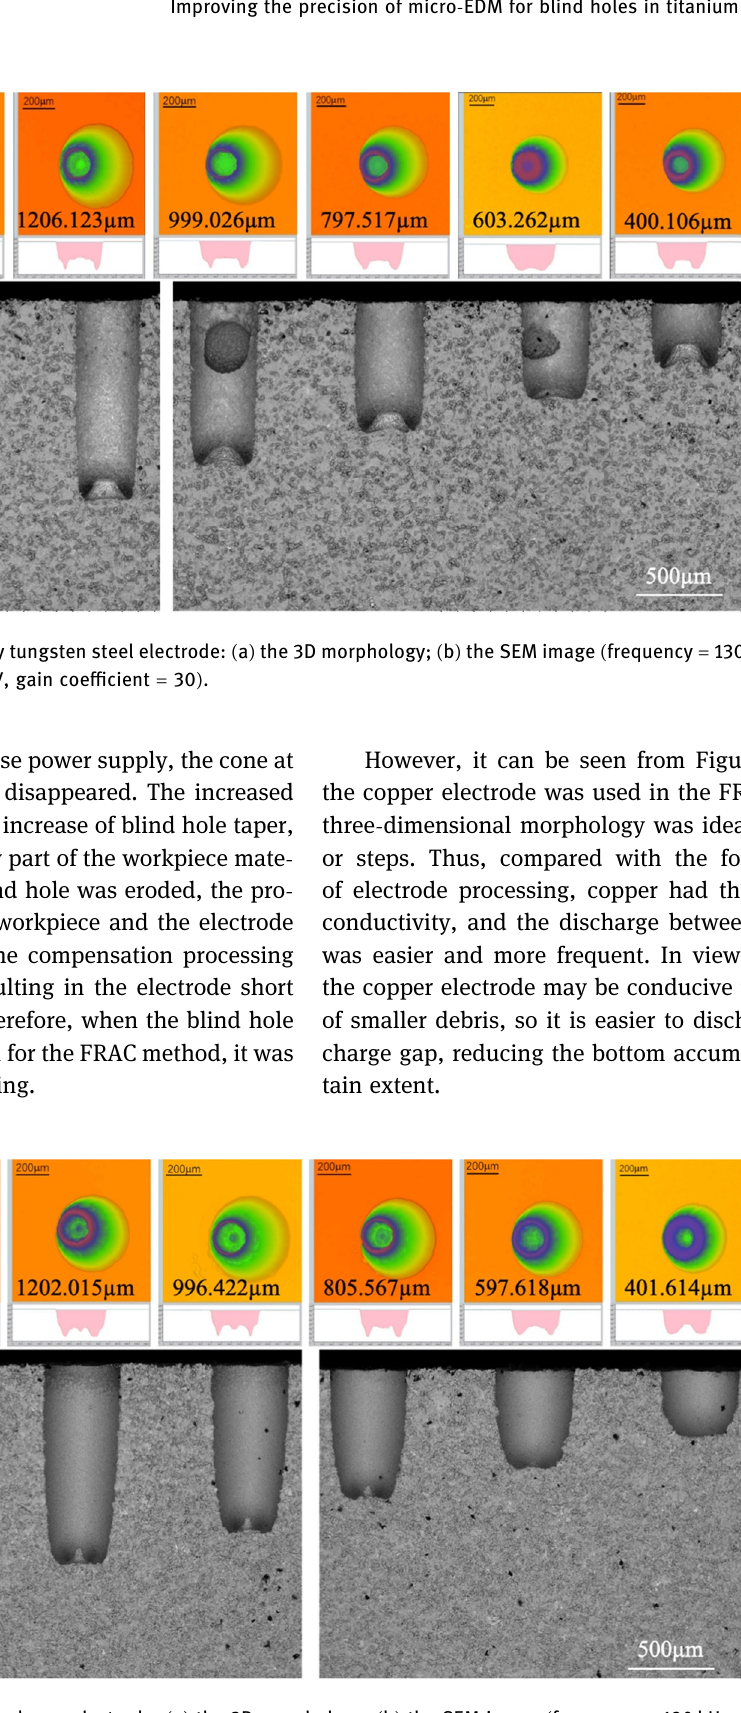
Figure 9: Blind holes processed by brass electrode: ( a ) the 3D morphology; ( b ) the SEM image ( frequency = 120 kHz, pulse width = 3 µs, current = 2.5, voltage = 90 V, gain coe ffi cient = 15 )